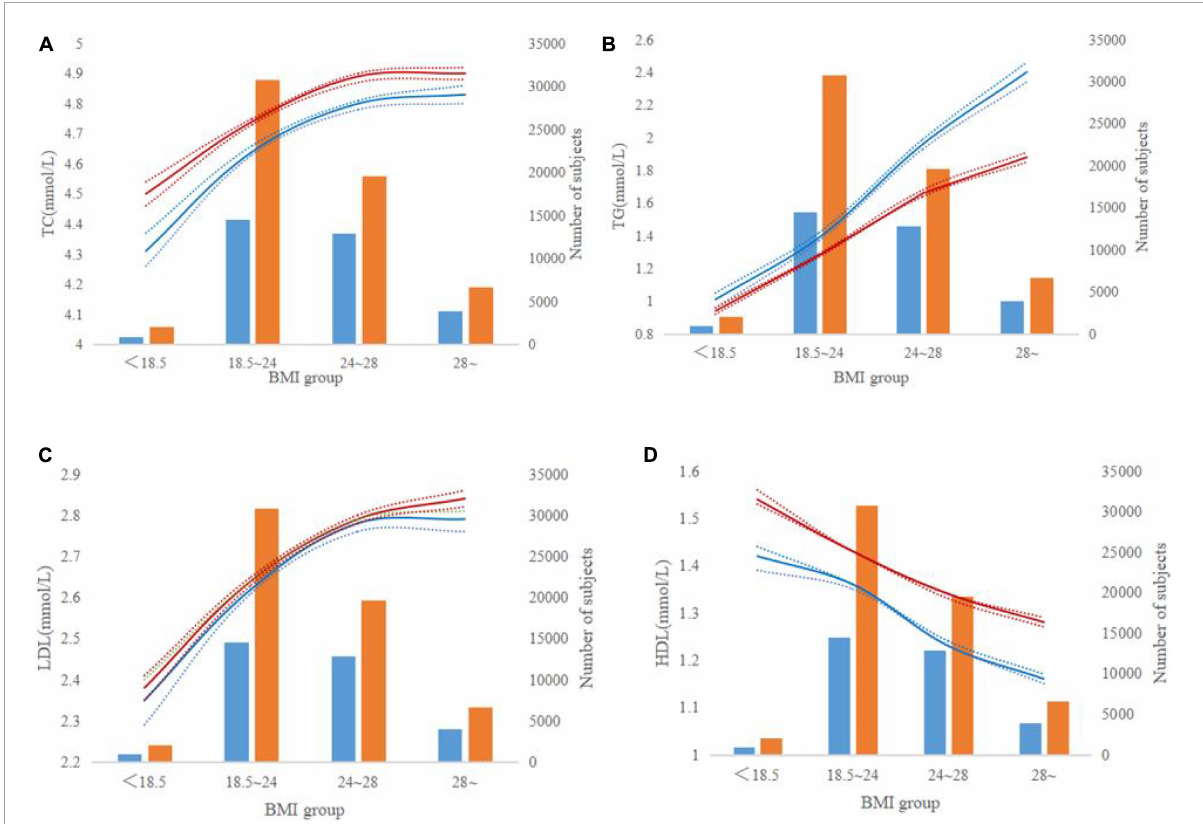
FIGURE2 Lipid levels according to body mass index groups. (A–D) The red and blue lines indicate trends for males and females, respectively. The dotted line represents a 95% confidence interval and the bars represent the number of males and females. (A–D) Represent TC, TG, LDL, and HDL levels by BMI